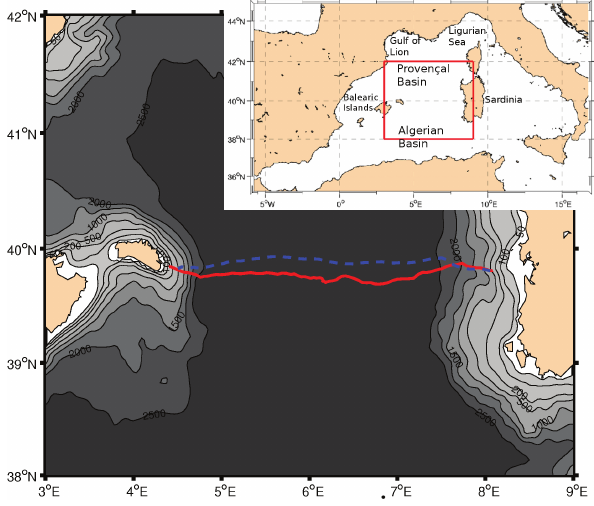
Figure 1. The route of the glider superimposed on the bathymetry in the studied area. Both outbound (west-to-east, red line) and return (east-to-west, blue line) tracks are shown. The bathymetry has been extracted from the US Navy Digital Bathymetric Data Base (1 / 60 ◦ of